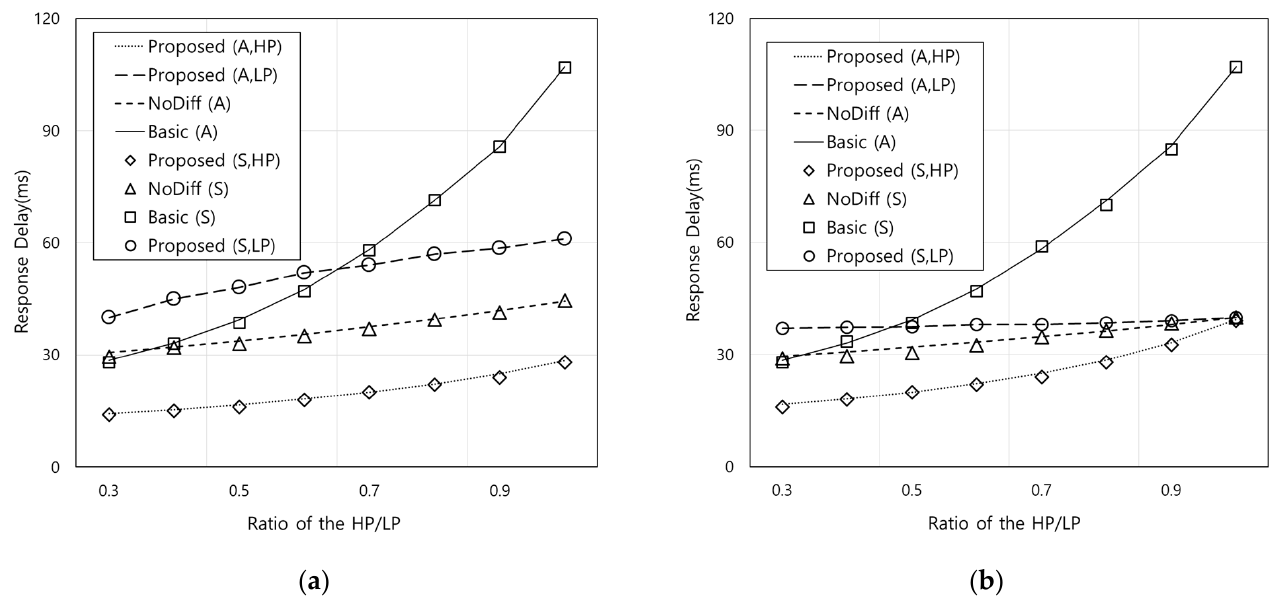
Figure 5. Response delay according to the ratio of HP flow arrival rate to LP flow arrival rate (A: analytic results, S: simulation results): ( a ) η = 1/3, ξ = 1/3, ( b ) η = 2/3, ξ = 1/3.